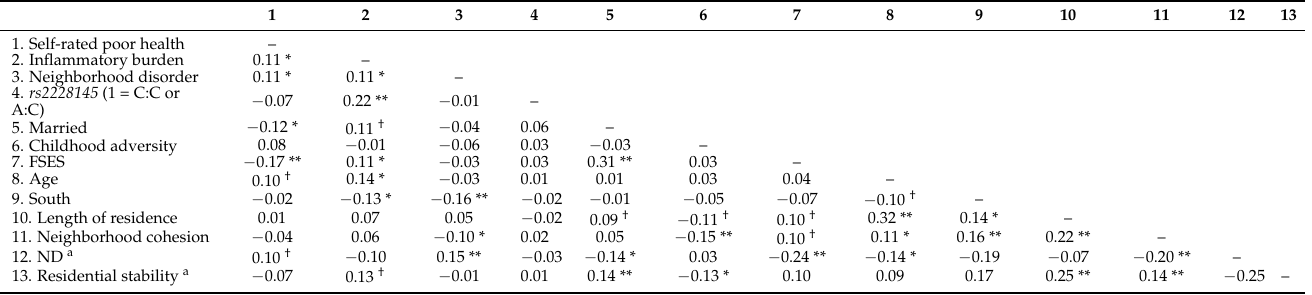
Table 2. Correlation matrix for the study